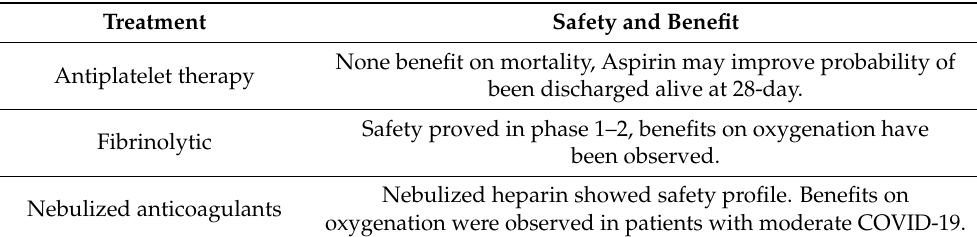
Table 1. Other antithrombotic treatments. Treatment Safety and Benefit Antiplatelet therapy